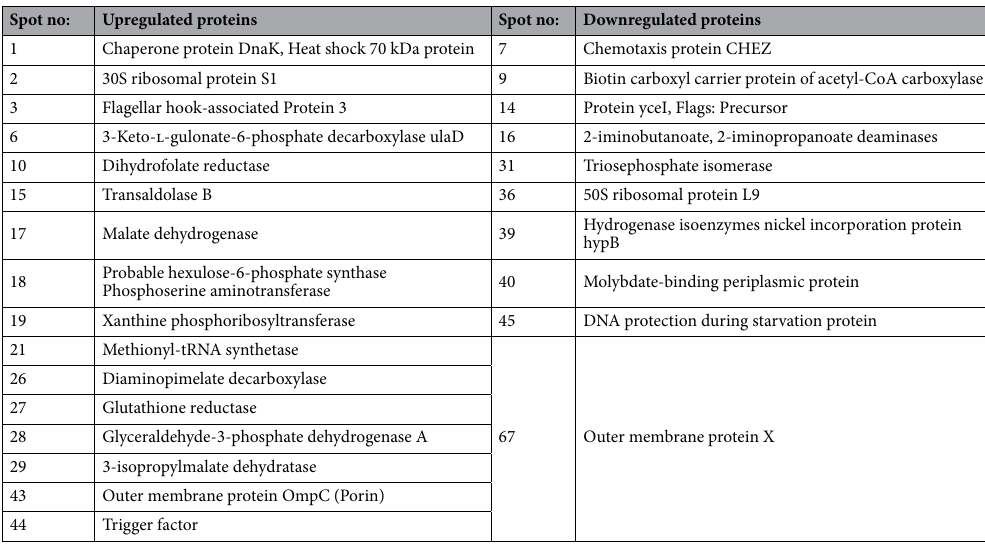
Table 4. Differently expressed proteins of E. coli after limonene treatment.